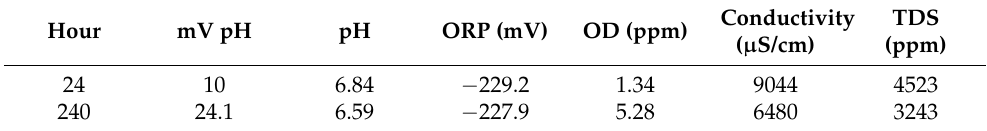
Table 1. Initial and final physico-chemical